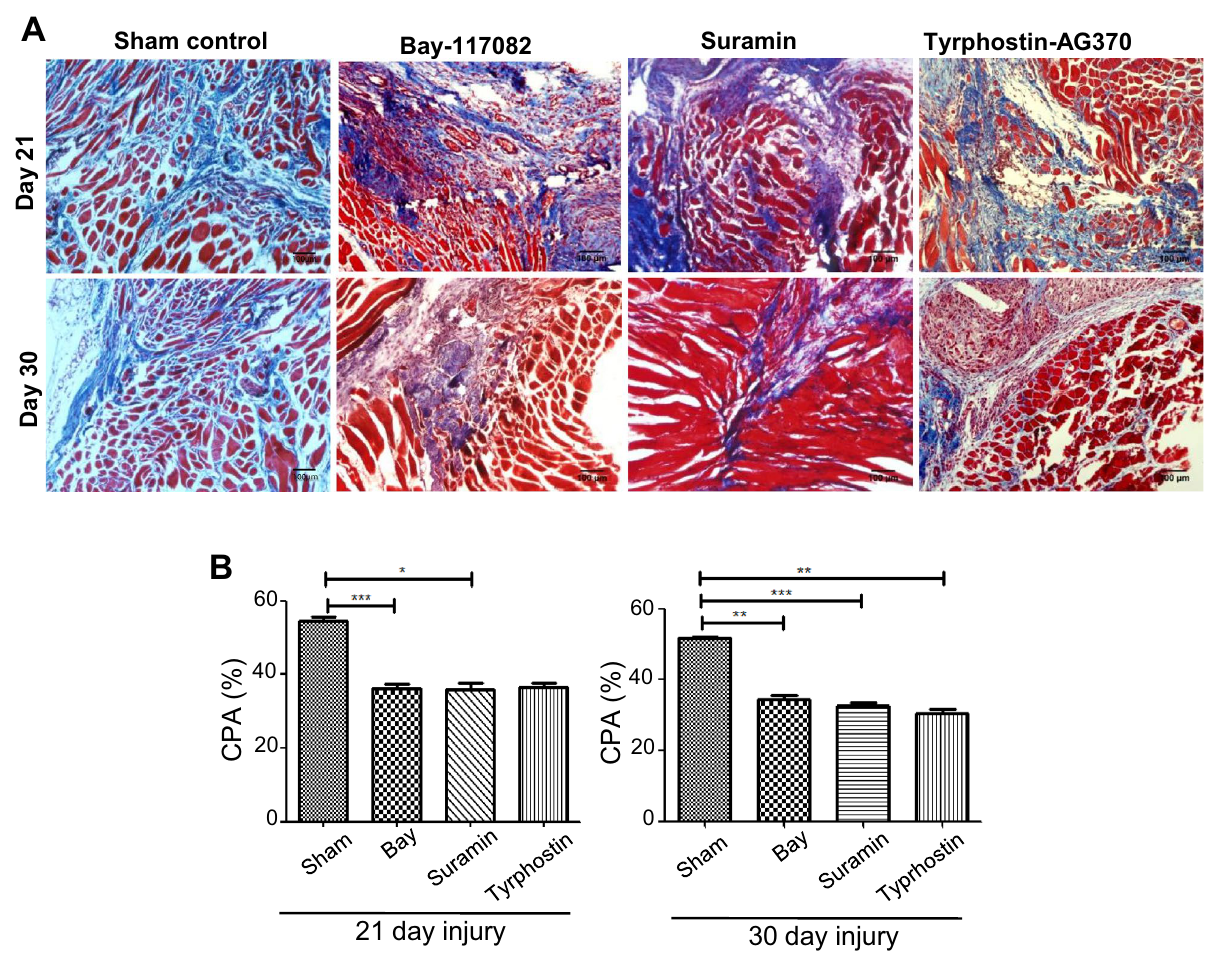
Figure 5. Histological evaluation of tissue sections following inhibitions of specific signaling. ( A ) Masson’s trichrome stained sections. Four groups of lacerated mice on day 14 of injury received one injection each of vehicle (sham control), Bay117082, Suramin and Tyrphostin AG-370. Seven days post injection (day 21) and 16 days (day 30) of the injury, the tissue sections were stained with Masson’s trichrome stain. ( B ) Collagen proportionate area (CPA). The CPA was calculated on the basis of morphometric analyses of 21 fields (10× magnification) of each condition using the ImageJ software. Data were presented as mean ± SEM. ***p < 0.001, **p < 0.01, *p <